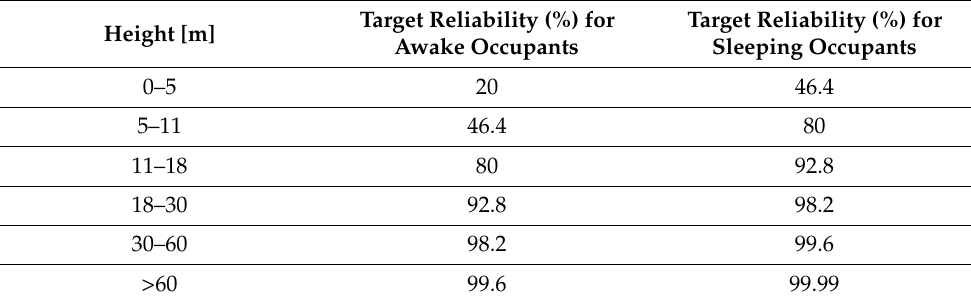
Table 1. Target reliability in function of height from Kirby et al. Target Reliability (%) for Height [m] Awake Occupants